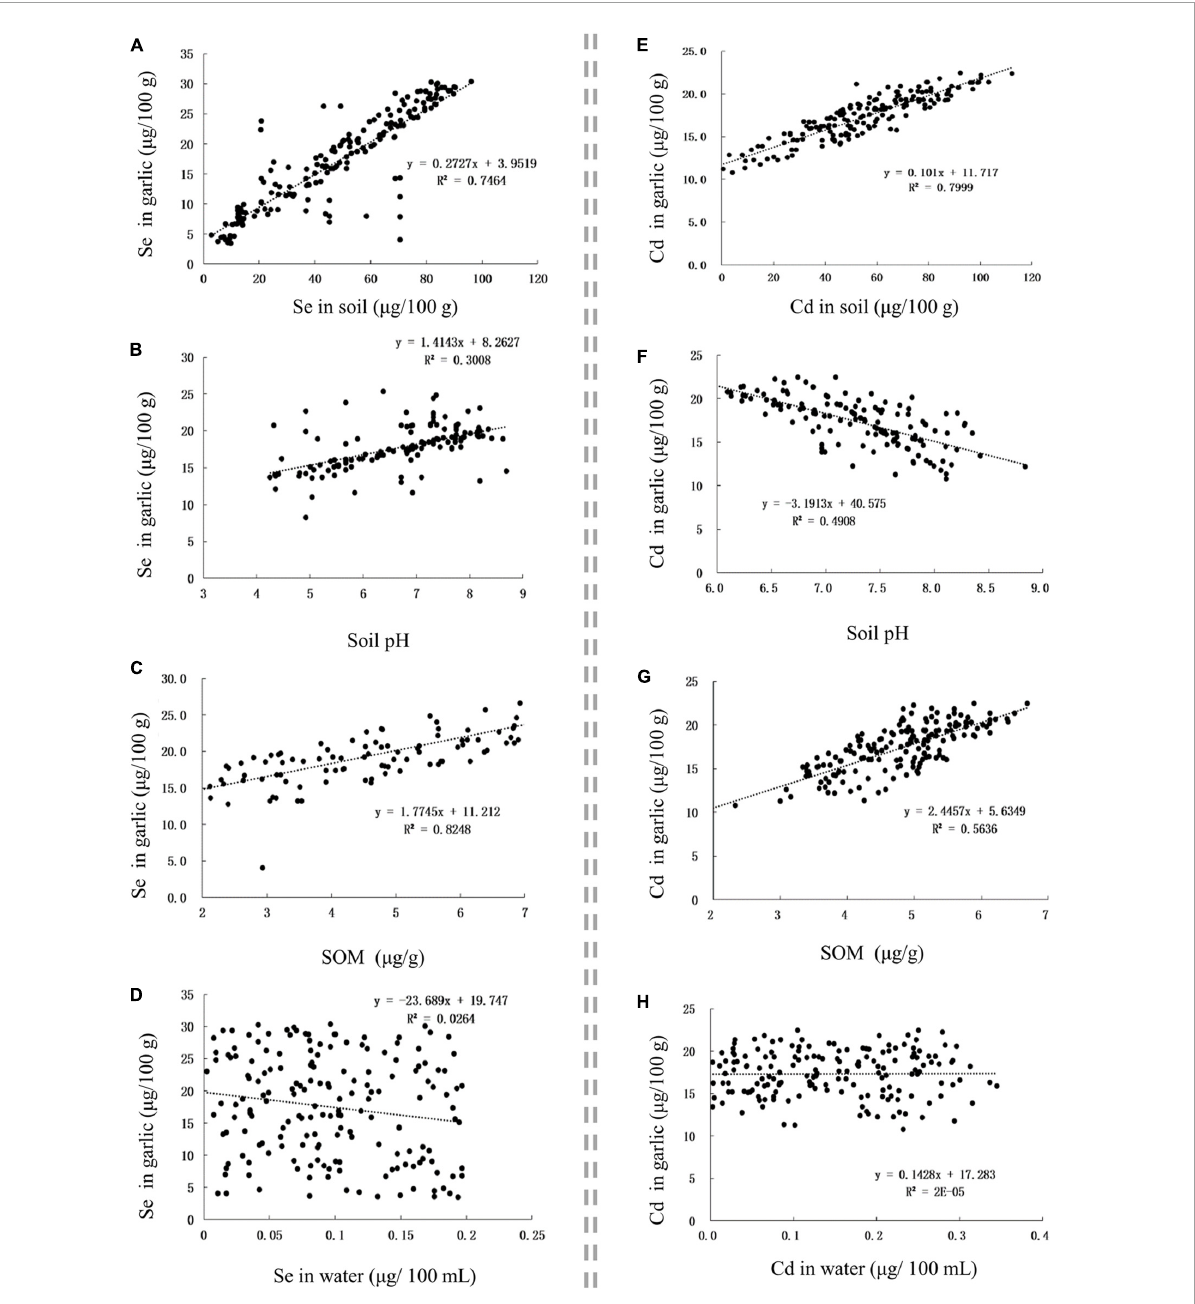
FIGURE4 The influence of factors on Se and Cd contents in garlic. (A–D) The influence of Se content in soil, soil pH, SOM, and Se content in water on Se content in garlic, respectively. (E–H) The influence of Cd content in soil, soil pH, SOM, and Cd content in water on Cd content in garlic,